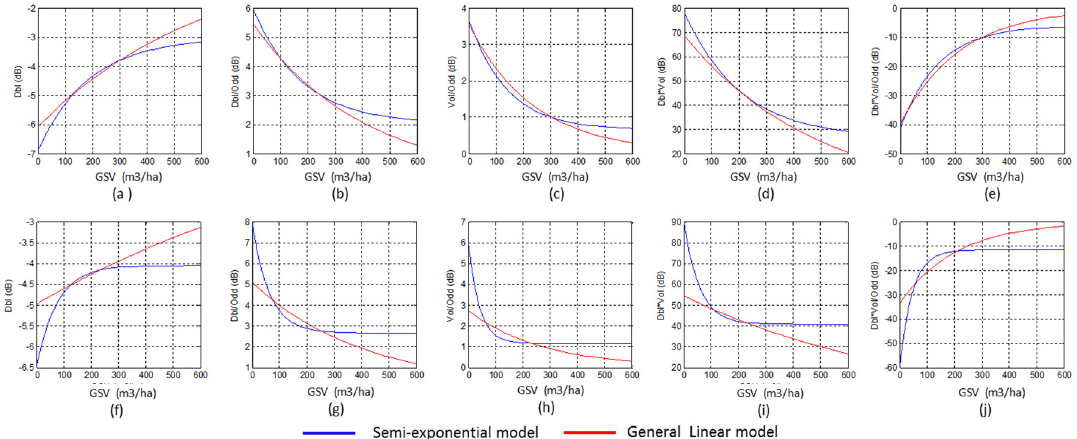
Figure 6. The fitted curves estimated by GLM and the semi-exponential model from single SAR image, ( a – e ) using the polarimetric characteristics from the image acquired on 30 June 2016 and ( f – j ) the image acquired on 22 September 2016.